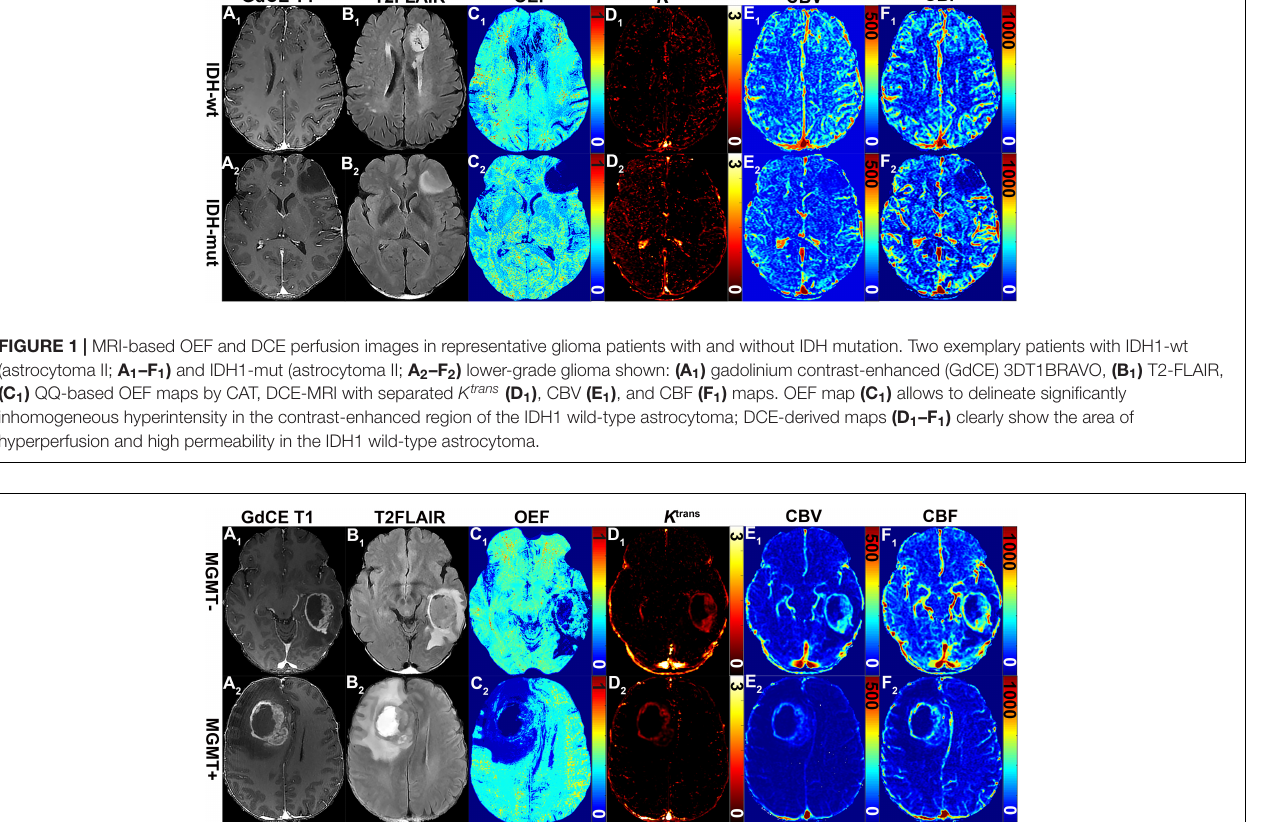
FIGURE 2 | Representative MRI-based OEF and DCE perfusion images of glioma patients with and without methylated MGMT promoter. Two GBM patients with unmethylated (51-year-old woman with MGMT - : A 1 –F 1 ) and methylated (58-year-old man MGMT + : A 2 –F 2 ) promoter shown: (A 1 ) GDCE 3D T1BRAVO, (B 1 ) T2-FLAIR, (C 1 ) QQ-based OEF maps with CAT, DCE-MRI with separated K trans (D 1 ) , CBV (E 1 ) , and CBF (F 1 ) maps. OEF map (C 1 ) allows to identify a focal area of higher values within the lesion for patients with unmethylated MGMT promoter; DCE-derived maps (D 1 –F 1 ) show a tendency toward higher signal